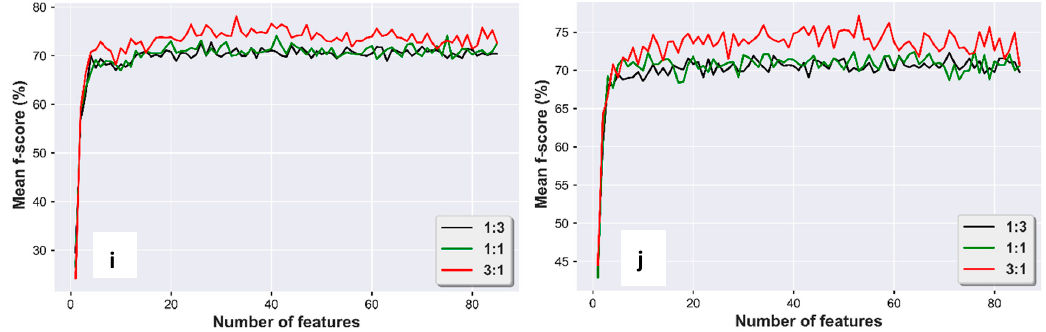
Figure 2. Mean f-score learning curve of trace ratio ( a ), ReliefF ( b ), Gini-index ( c ), F-score ( d ), LS_121( e ), LL_121 ( f ), JMI ( g ), MIM ( h ), svm-b ( i ), dt-f ( j ) for different feature subsets (Features are made of 75 VIs and 10 Sentinel-2 bands).